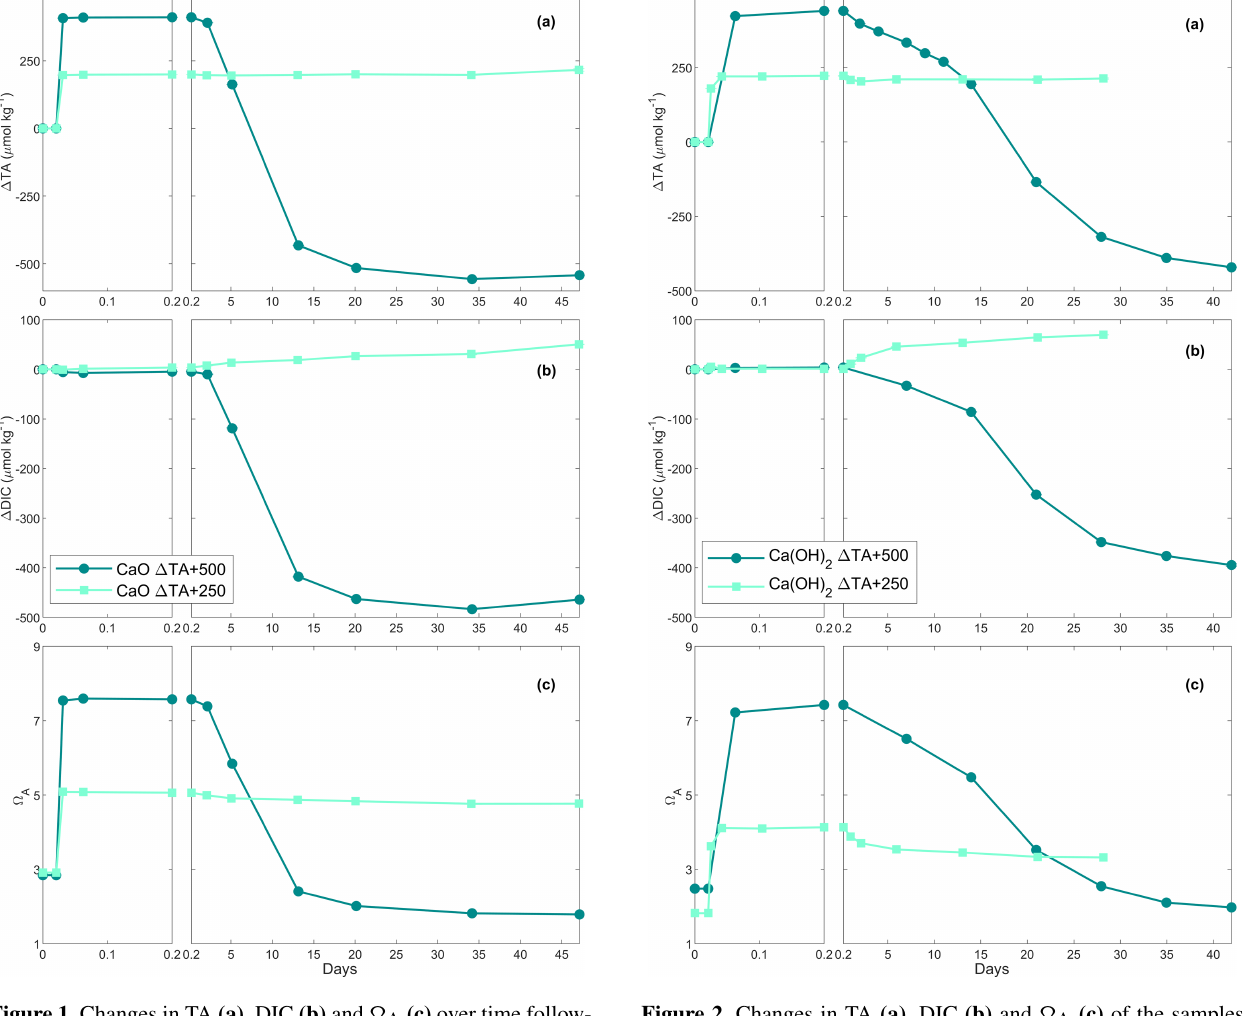
Figure 1. Changes in TA (a) , DIC (b) and (cid:127) A (c) over time follow- ing two CaO additions.